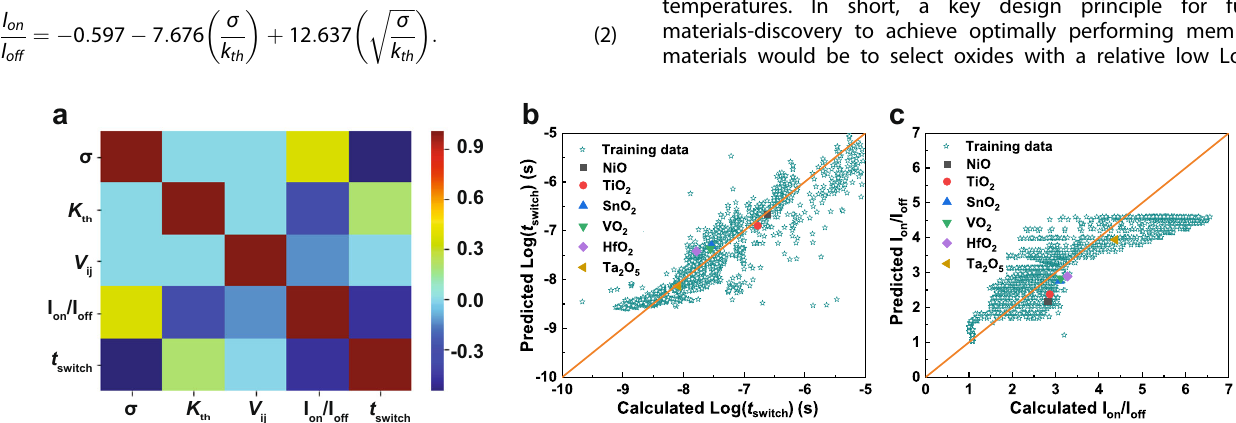
Fig. 5 Machine learning results. a The Pearson correlation plot between the different material-characteristics and the performance metrics. The SISSO model fi ts to the data using a 2D-descriptor for b t switch and c I on / I off